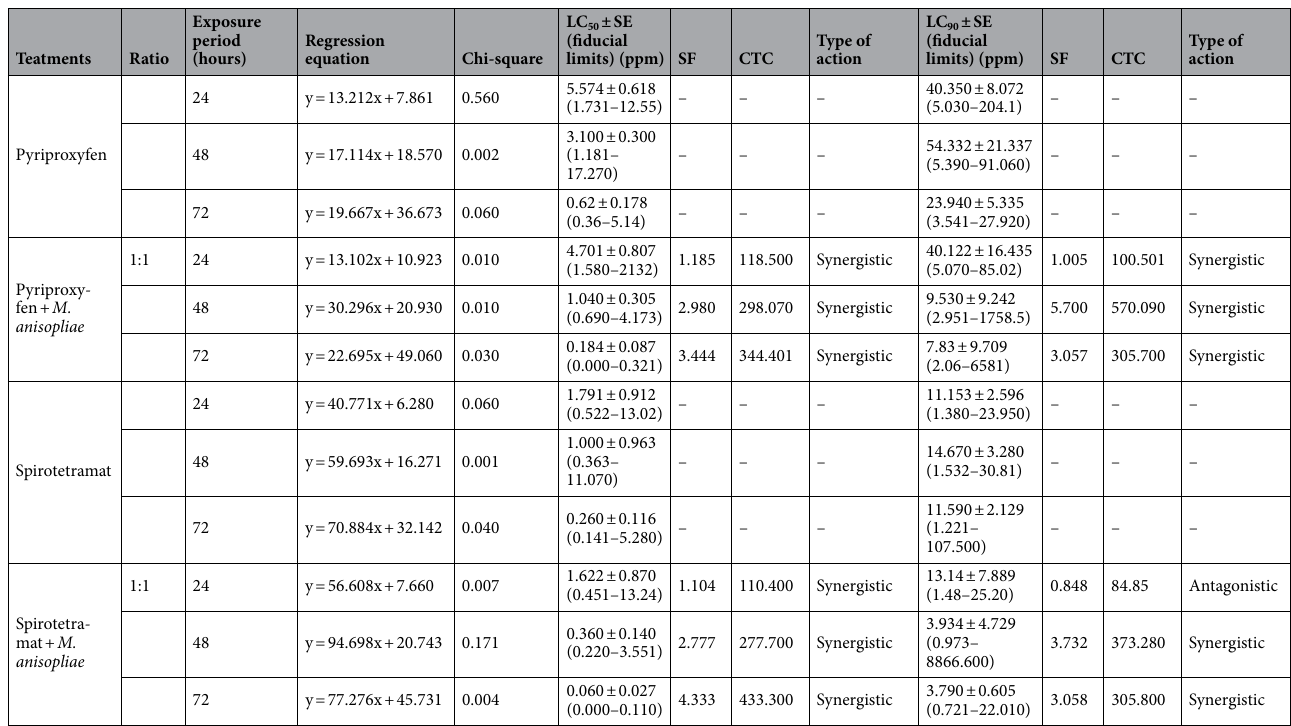
Table 4. Toxicity of insecticides (Pyriproxyfen and Spirotetramat) with and without M. anisopliae for A. gossypii. CTC co-toxicity coefficient, SF synergy